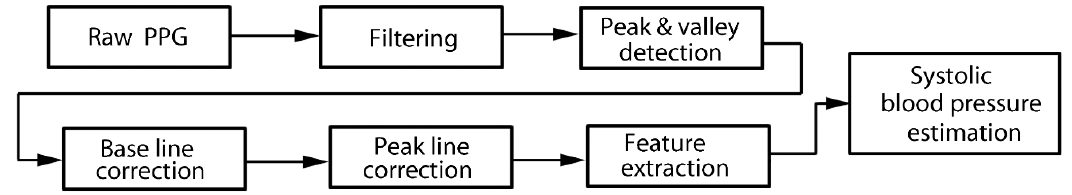
Figure 2. The block diagram of the proposed methodology. PPG: Photoplethysmogram.